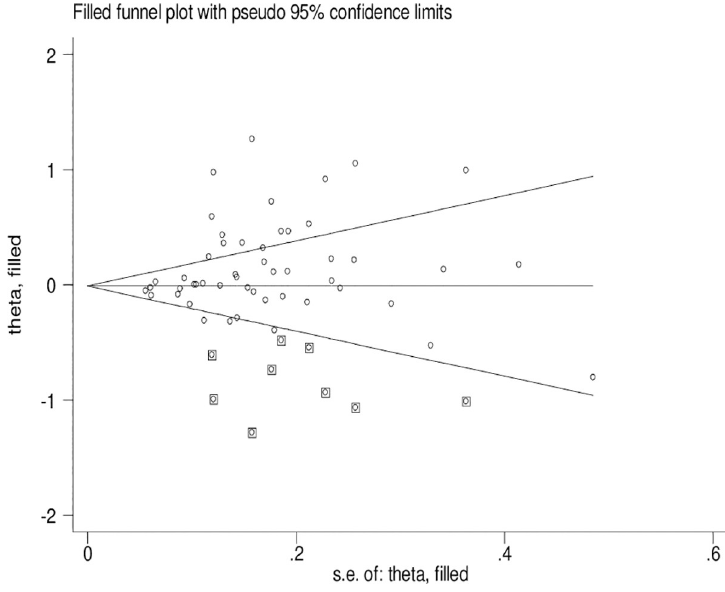
Fig 3. The duval and tweedie nonparametric “trim and fill” method’s funnel plot of the CYP1A1 T3801C polymorphism (C vs. T).